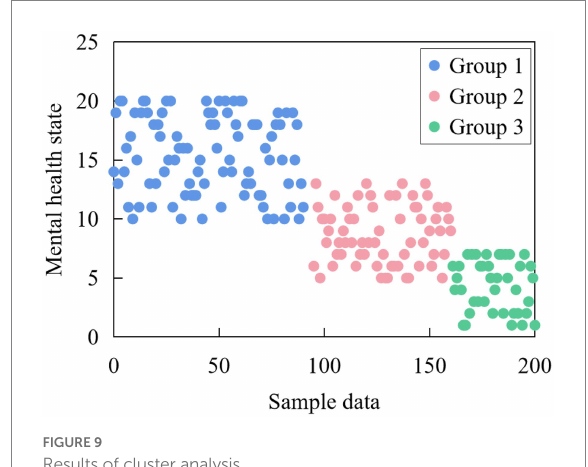
FIGURE 9 Results of cluster